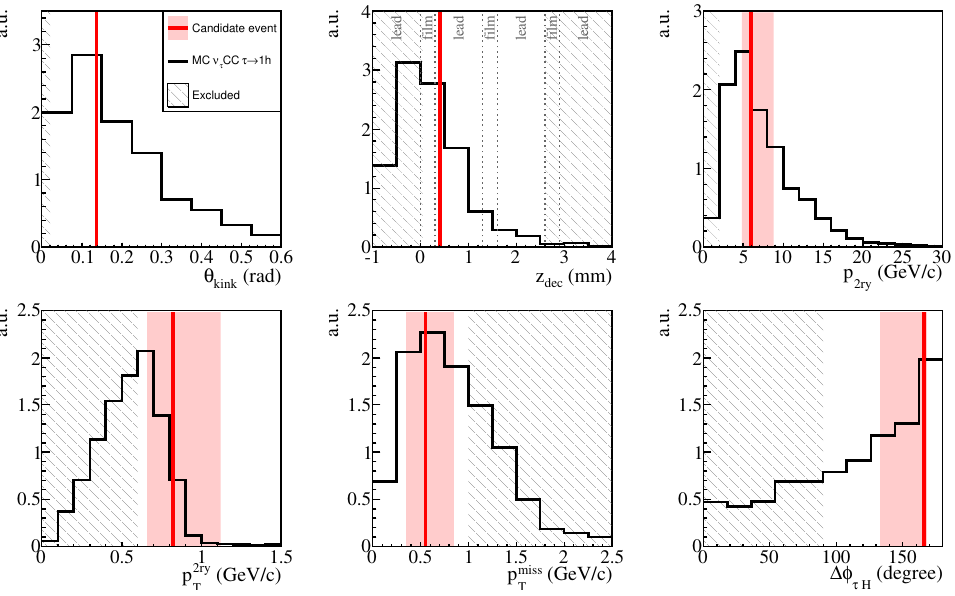
Figure 5. MC distributions of the kinematical variables used to select candidate events in the τ → 1 h decay